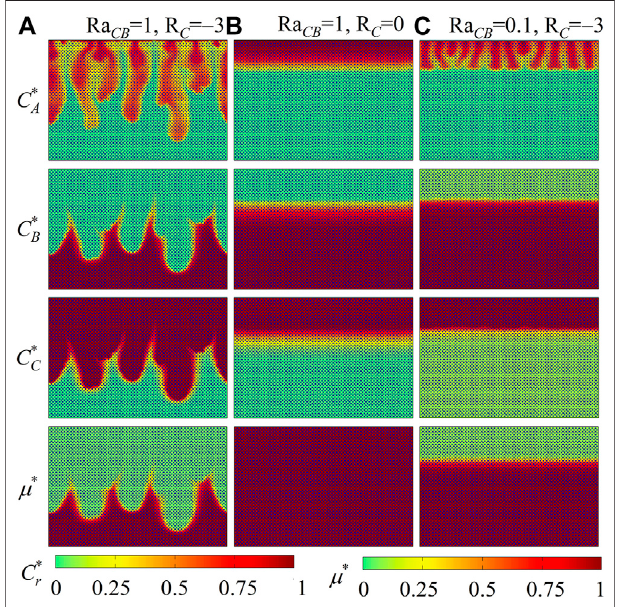
FIGURE 7 | Contours of species concentrations C * r and fl uid viscosity μ * forcaseswithRa AB (cid:2) 0.1andR A (cid:2) 0and (A) Ra CB (cid:2) 1,R C (cid:2)− 3,at t * (cid:2) 800, (B) Ra CB (cid:2) 1, R C (cid:2) 0, at t * (cid:2) 900, and (C) Ra CB (cid:2) 0.1, R CB (cid:2) − 3, at t * (cid:2) 900.